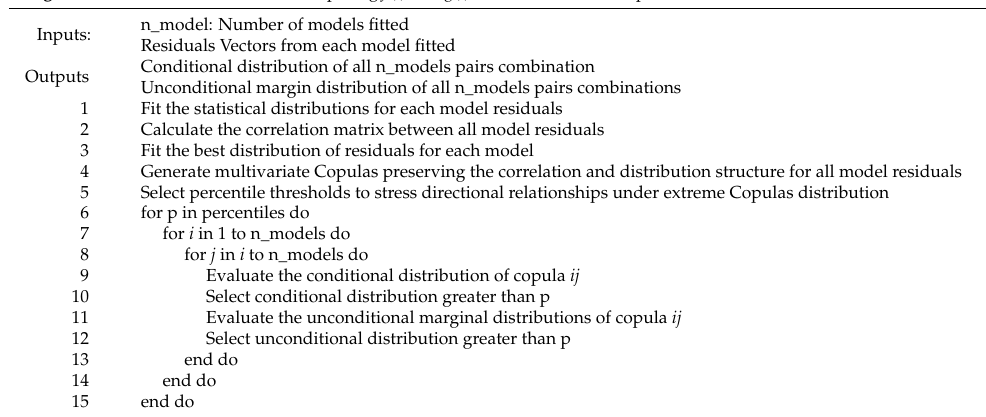
Algorithm 1 Pseudo code used for computing f (.) and g (.) estimates used in Step 2